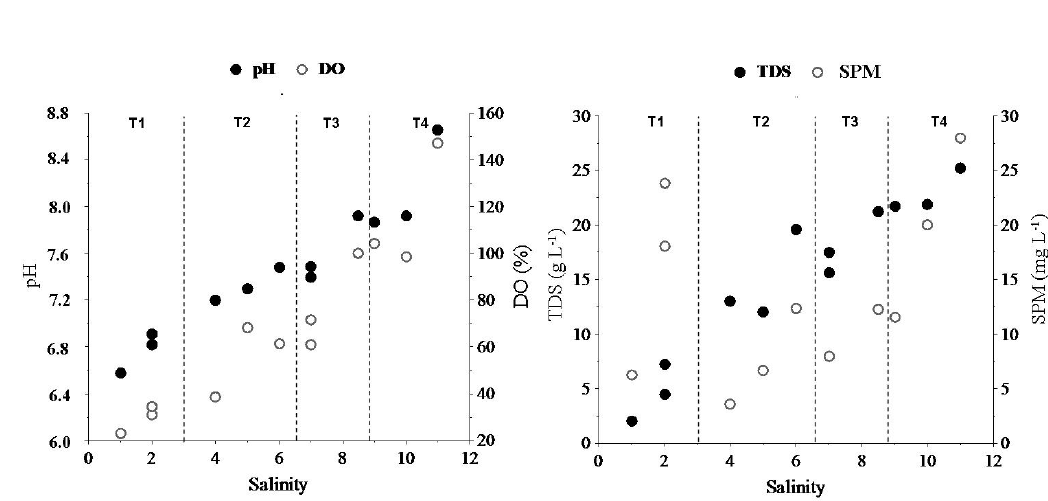
Figure 2. Mixture diagram (p<0.95 Conf. Int.) of pH, dissolved oxygen, total dissolved solids and suspended particulate matter, at Iguaçu River mouth in a salinity gradient from 0 to 12, Guanabara bay, Rio de Janeiro State,